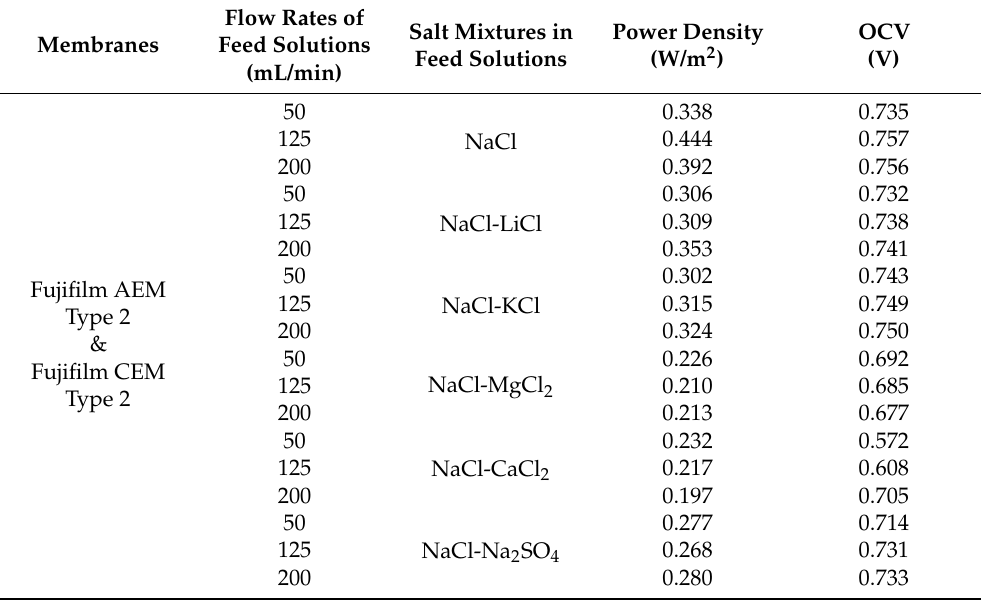
Figure 9. Power density vs. current density plots at different feed flow rates for the studies performed with ( a ) a mixture of NaCl and MgCl 2, ( b ) a mixture of NaCl and CaCl 2, ( c ) a mixture of NaCl and Na 2 SO 4 using Fujifilm AEM Type 2 & CEM Type 2 membranes. Table 8. Power density and OCV results of the studies performed by Fujifilm AEM Type 2 and CEM Type 2 membranes.